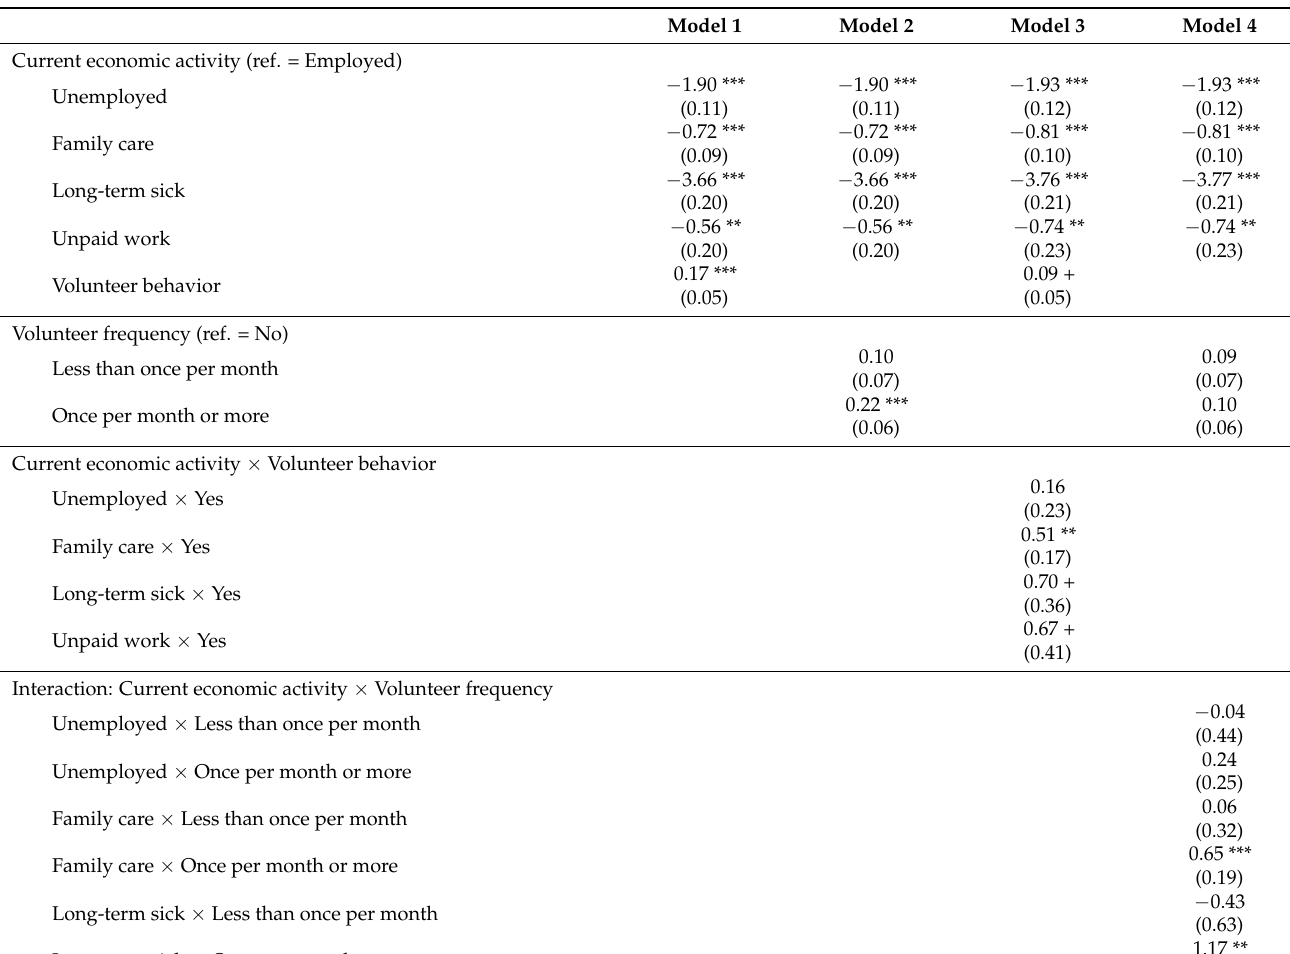
Table 2. Two-way fixed effects models predicting the effects of current economic activity type and voluntary participation on mental health (reversed